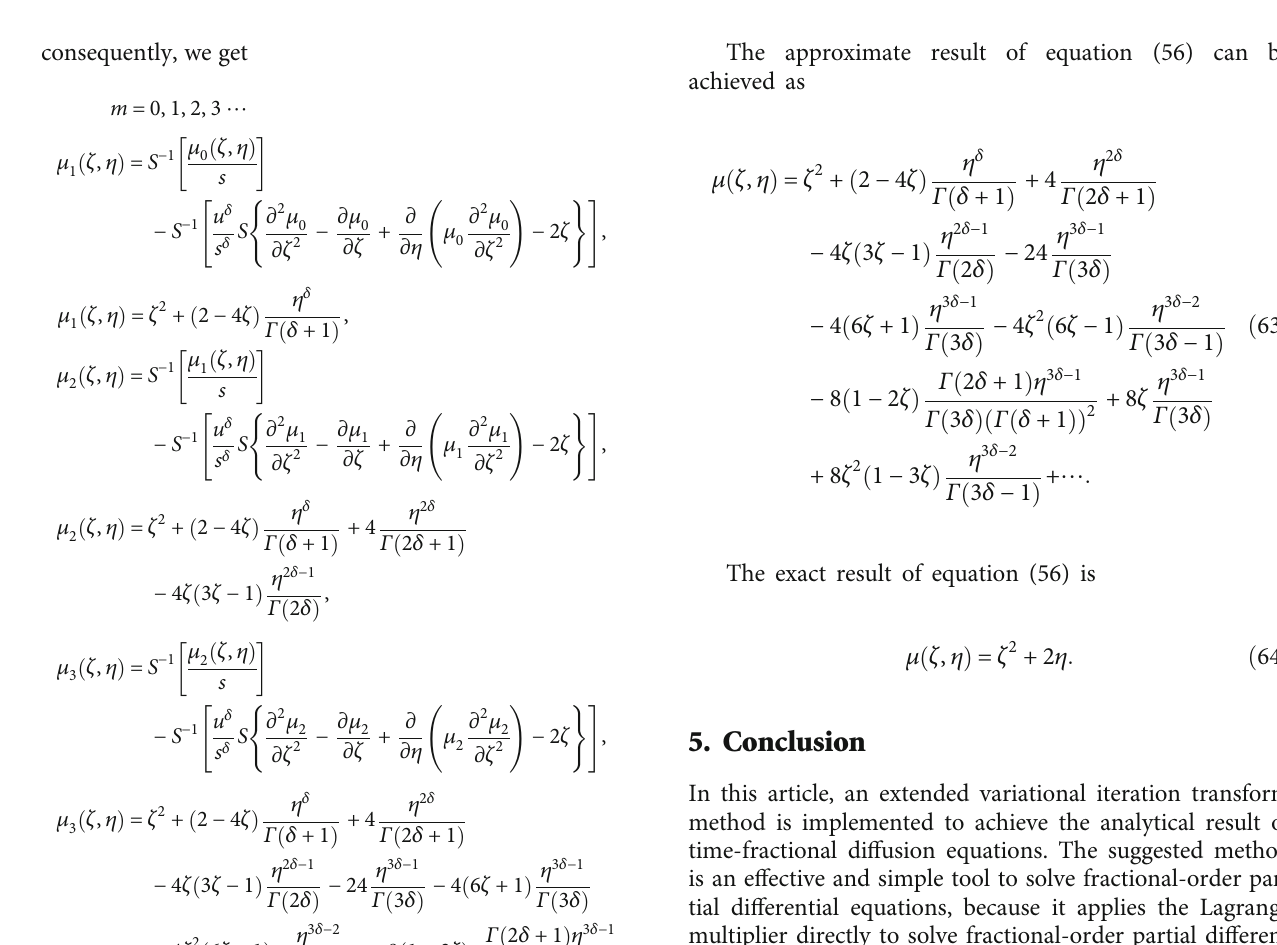
Figure 8: The fractional-order of δ = 0 : 8 and 0 : 6 of Problem